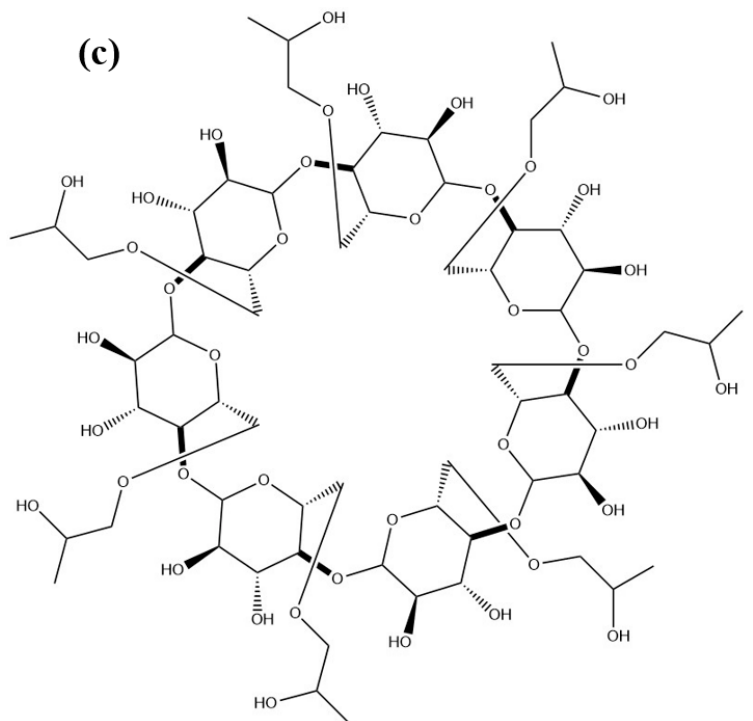
Figure 1. Chemical structures of OL ( a ), beta-CD ( b ), and HP-beta-CD ( c ). OL, oleuropein; beta-CD, beta-cyclodextrins; HP-beta-CD, hydroxypropyl-beta-cyclodextrins.